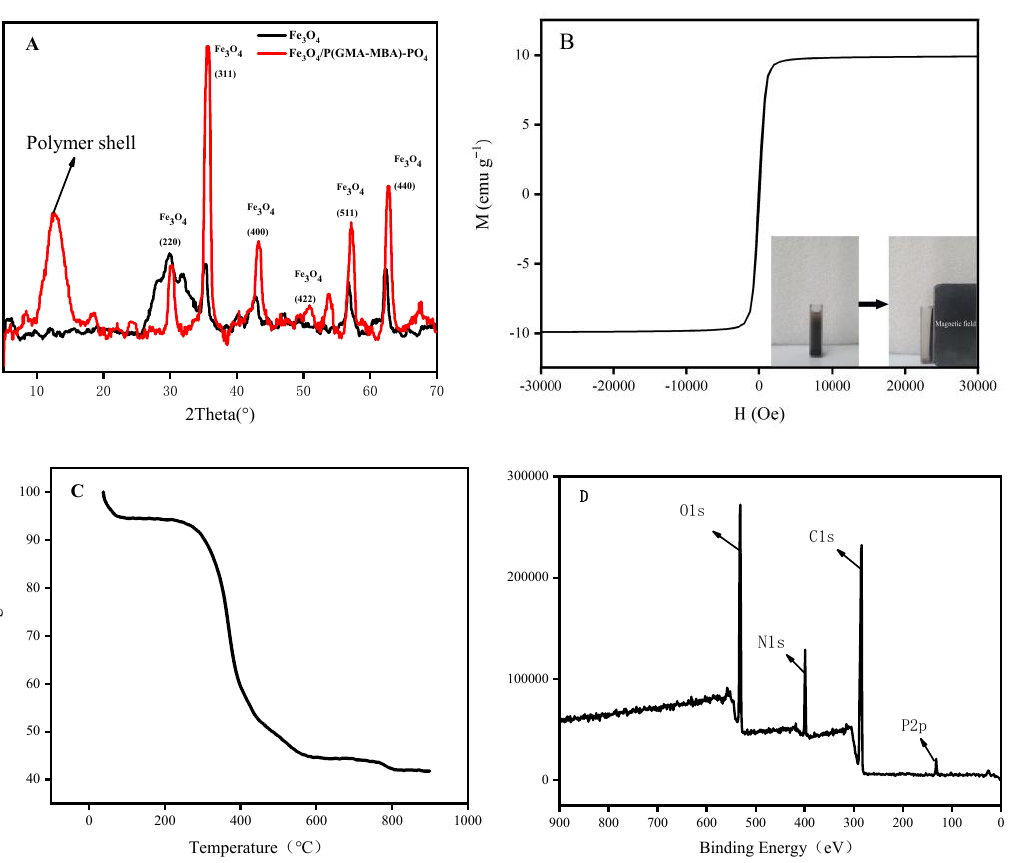
Figure 3. ( A ) XRD pattern of Fe 3 O 4 , and Fe 3 O 4 /P(GMA-MBA)-PO 4 ; ( B ) VSM curve; ( C ) TGA curve and ( D ) XPS spectrum of Fe 3 O 4 /P(GMA-MBA)-PO 4 .